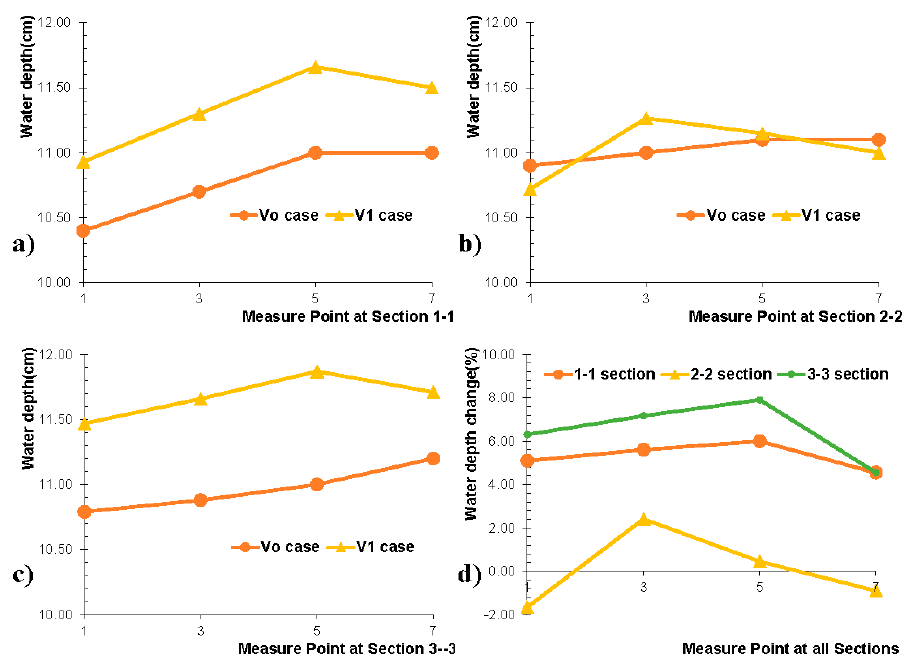
Figure 12. CFD -water depth changes (cm) in V 0 and V 1 case at ( a ) 1-1, ( b ) 2-2, ( c ) 3-3 sections and ( d ) % change for all sections.